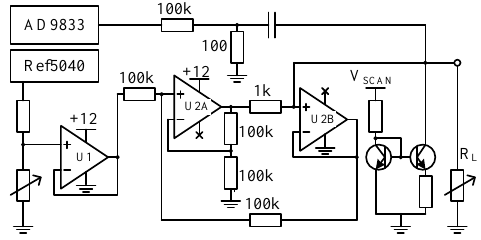
Figure 8. The current control circuits of the